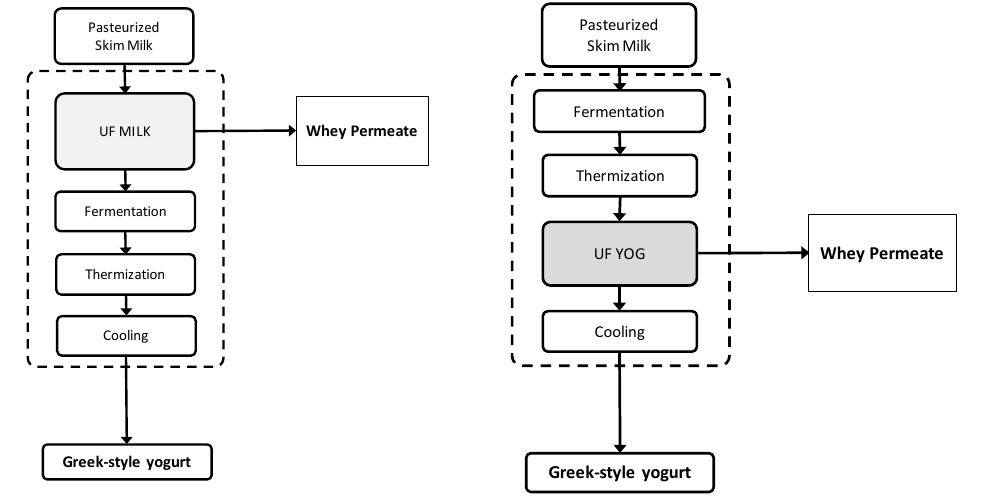
Figure 1. Greek-style yogurt (GSY) processing including ultrafiltration (UF) concentration step.